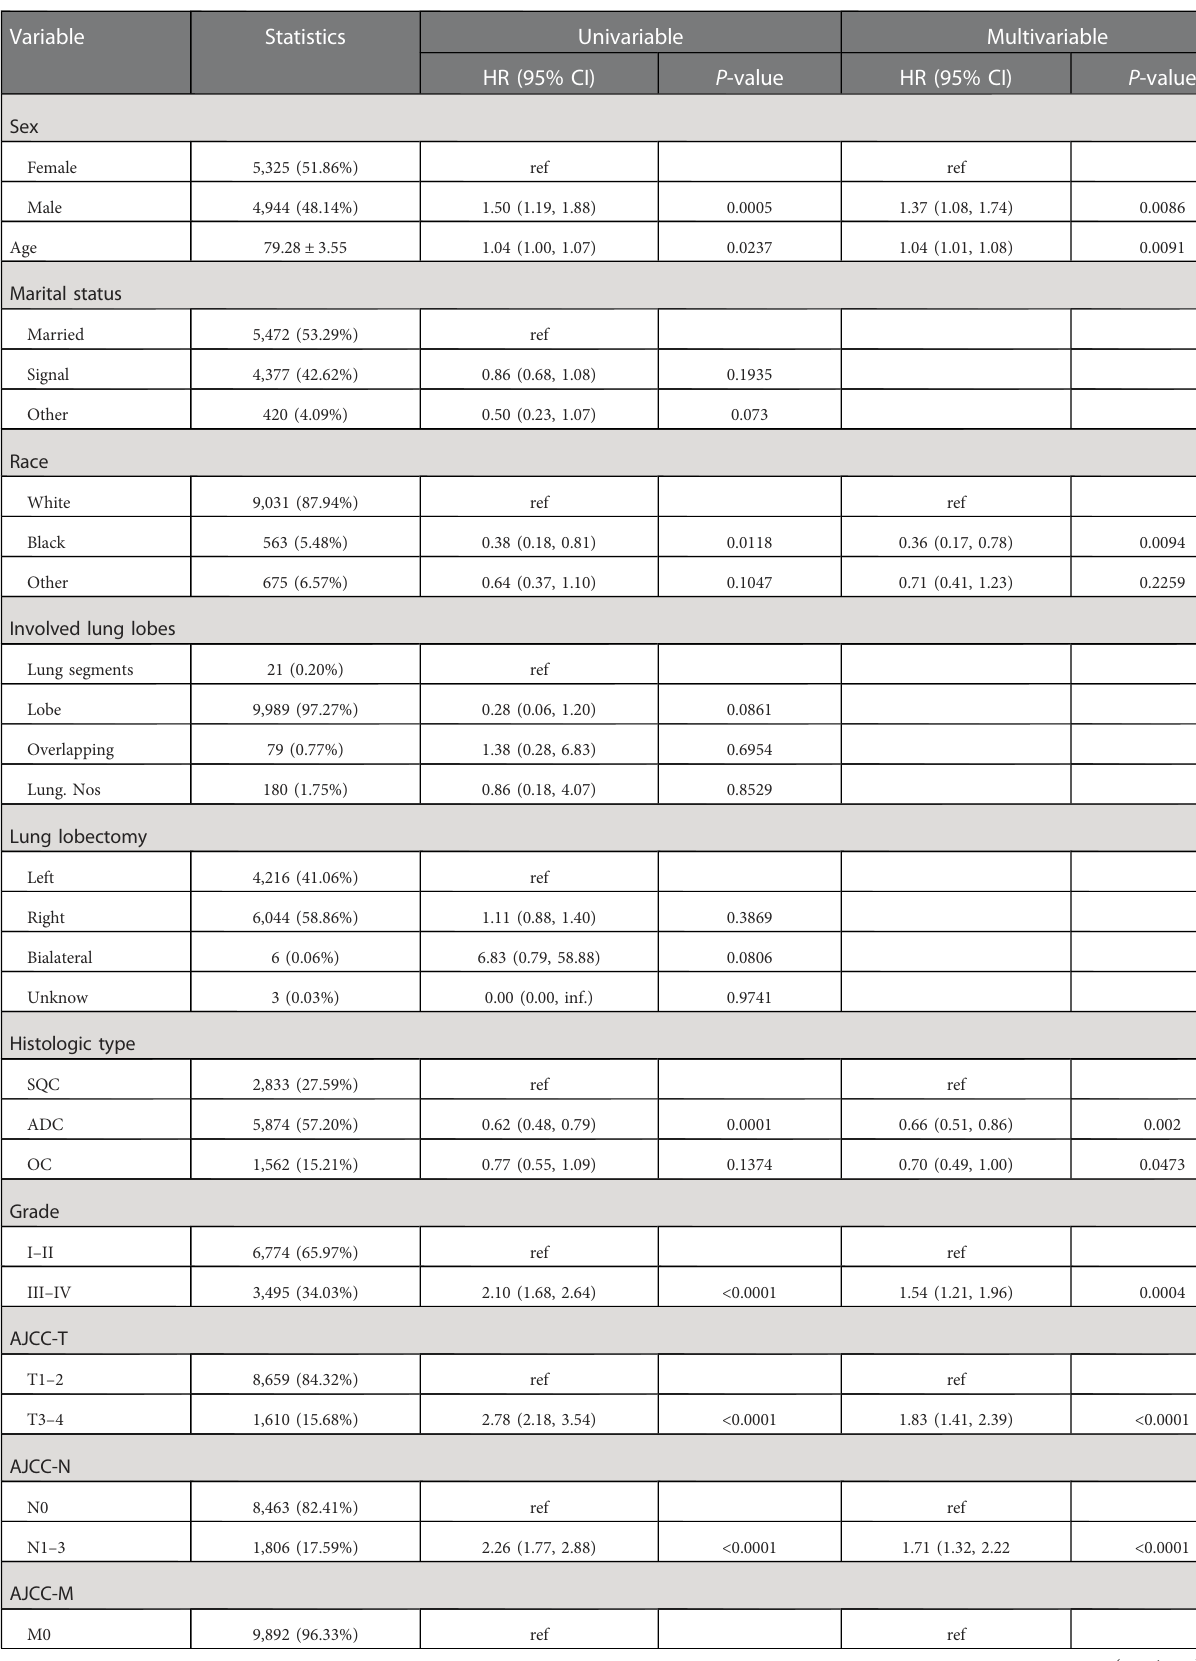
TABLE 2 Univariable and multivariable logistic regression analysis in development